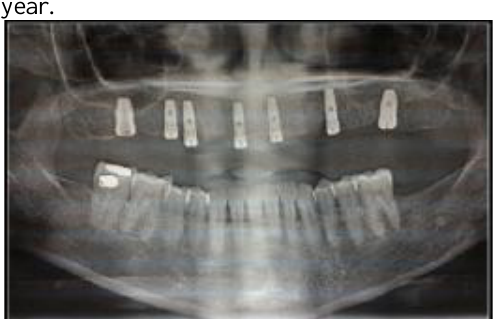
Figure 6: The Sinus Lift Balloon was Introduced beneath the Schneiderian Membrane within the SMS (Sinus Membrane Space) and Inflated.